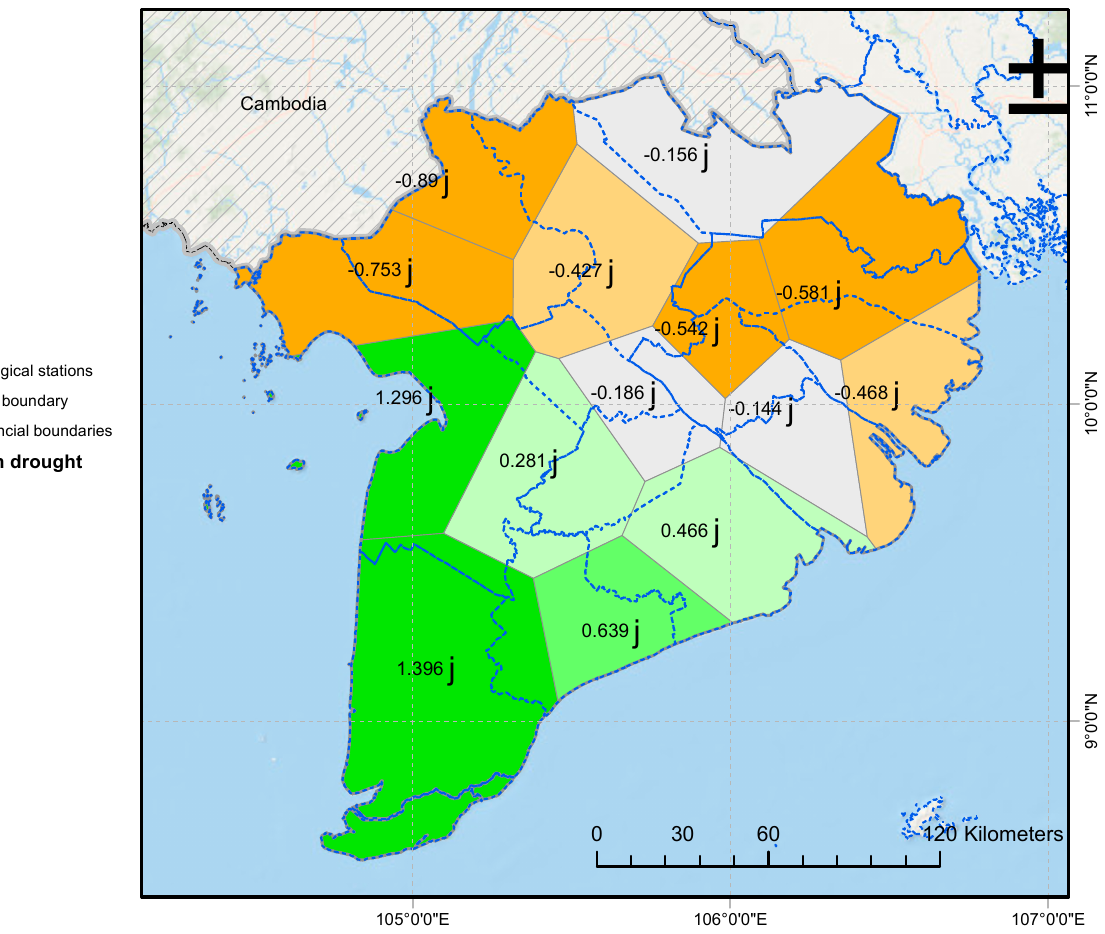
Figure 4. The mean SPI 12 ‐ month drought values using Thiessen polygon, during 1980 and 2019.